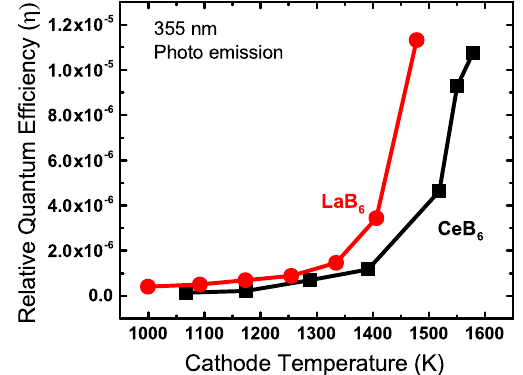
FIG. 6. Photoemission properties of LaB 6 and CeB 6 irradiated by 355 nm.